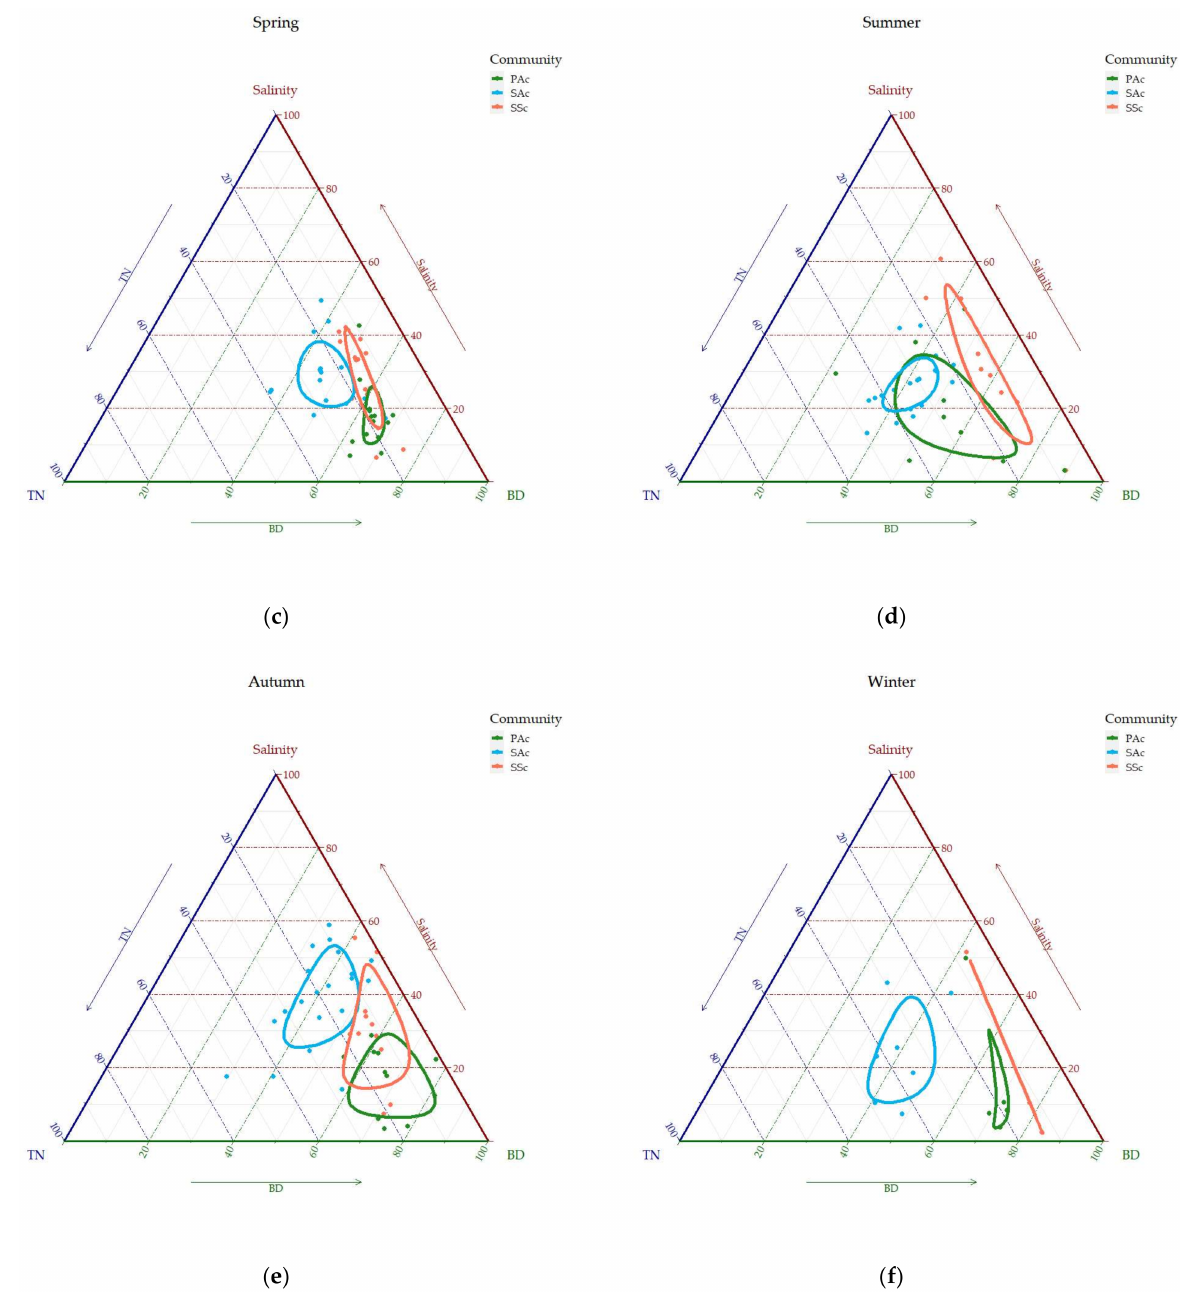
Figure A2. Ternary plots of community distribution in different regions and seasons: ( a ) North; ( b ) South; ( c ) spring; ( d ) summer; ( e ) autumn; and ( f ) winter. Different colors represent different communities. The three soil factor data were normalized and the sum of the three equaled to one. Circles indicate 95% confidence